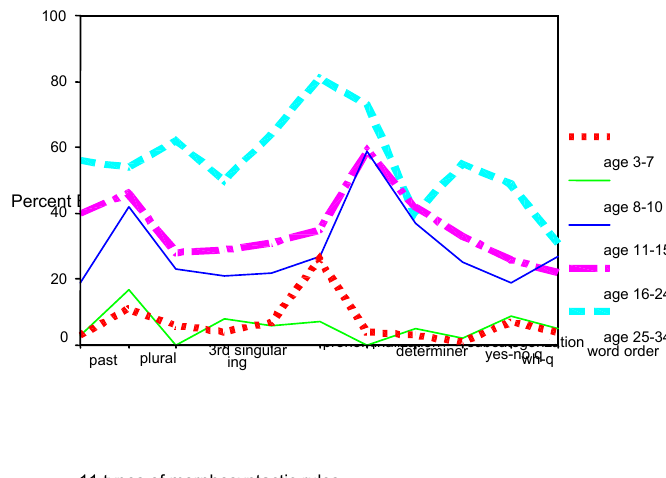
Mean Percentage of Errors on 11 Grammatical Rule Types